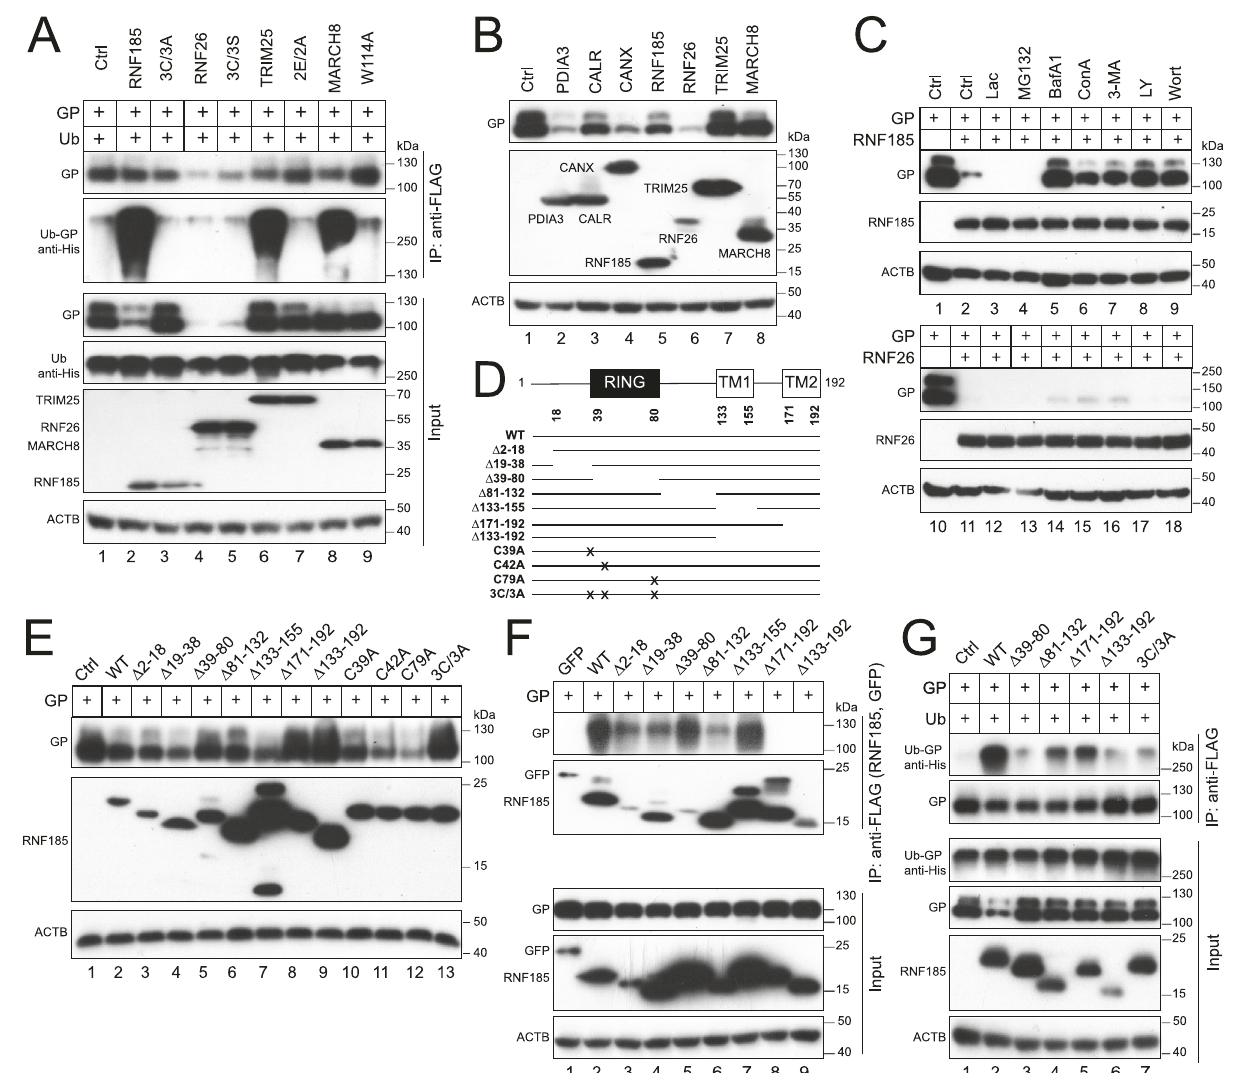
Fig. 8 | RNF185 polyubiquitinates and degrades EBOV-GP 1,2 (GP). A GP was expressed with His-tagged Ub in the presence of indicated E3 Ub ligases or their catalytically inactive mutants in HEK293T cells. GP and E3 proteins were immuno- precipitated and GP polyubiquitination was analyzed by WB. GP was detected by anti-EBOV-GP; RNF26, RNF185, and TRIM25 were detected by anti-FLAG; MARCH8 was detected by anti-HA; Ub was detected by anti-His. B GP was expressed with indicatedproteinsinHEK293Tcells.ProteinexpressionwasdeterminedbyWB.GP, RNF26,RNF185,TRIM25,andMARCH8weredetectedasin A ;PDIA3andCALRwere detected by anti-Myc; CANX was detected by anti-HA. C GP was expressed with RNF185orRNF26andtreatedwithindicatedinhibitorsaswedidpreviously.Protein expression was determined by WB. GP was detected by anti-EBOV-GP; RNF26 and RNF185 proteins were detected by anti-FLAG. D A schematic diagram of RNF185 is